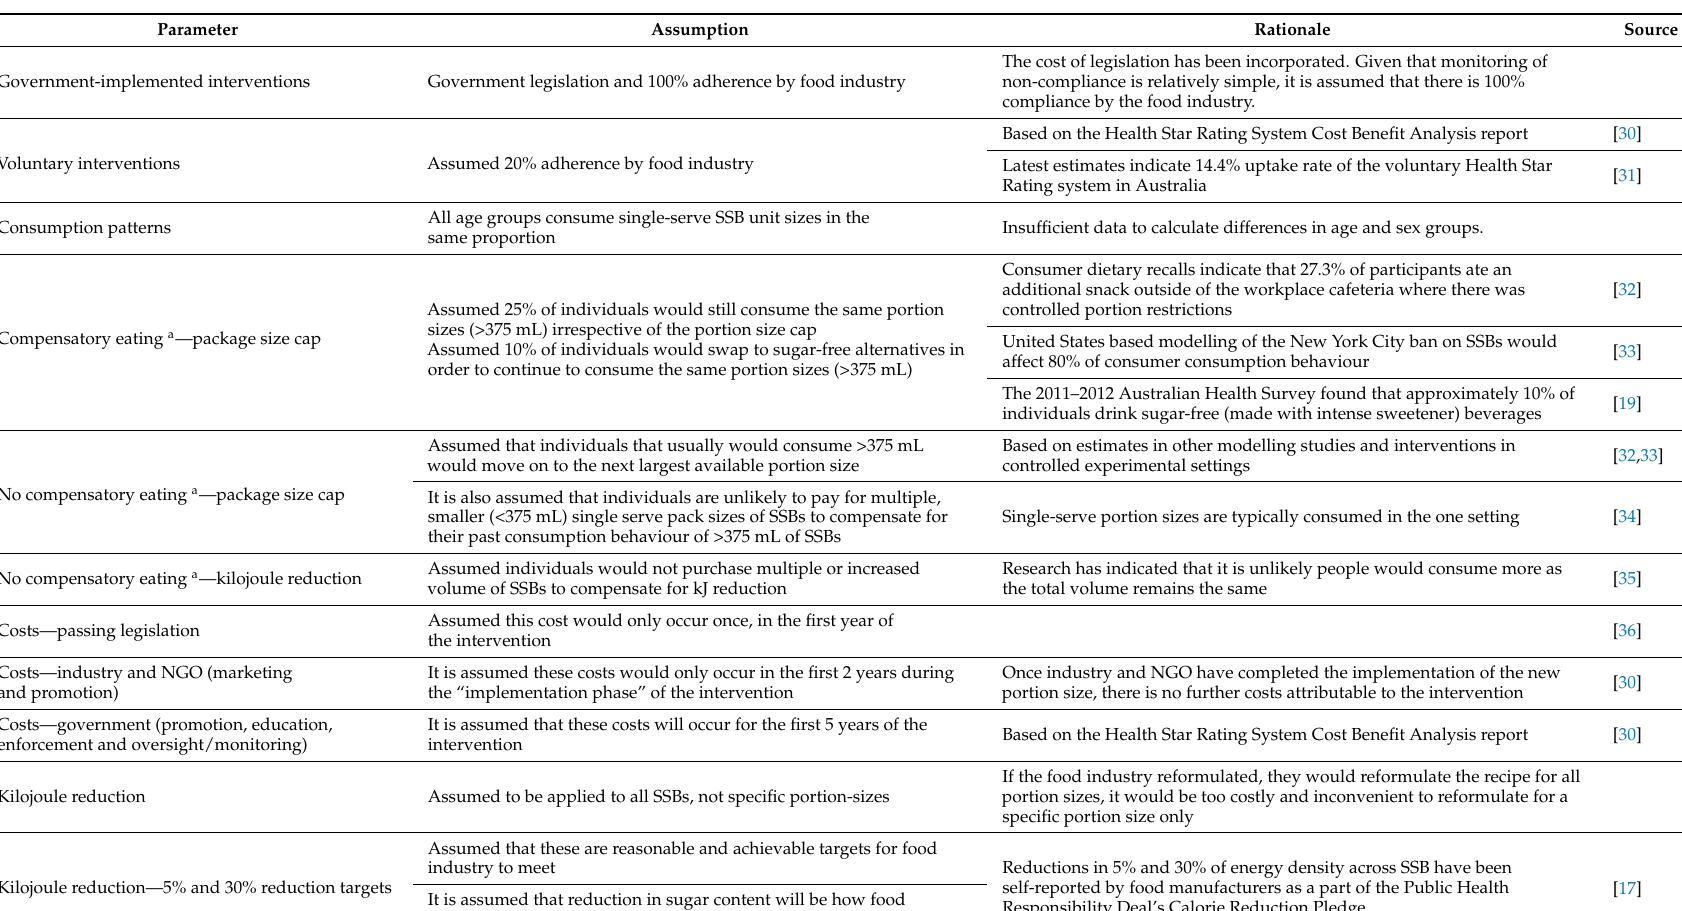
Table 2. Parameters, assumptions and rationale for modelled